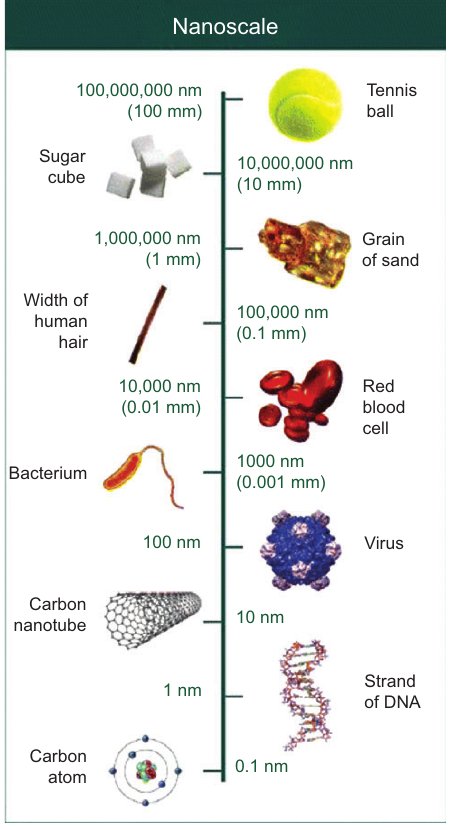
Figure 1 Nanochart showing relative scales of nanosized items to everyday objects [1] .